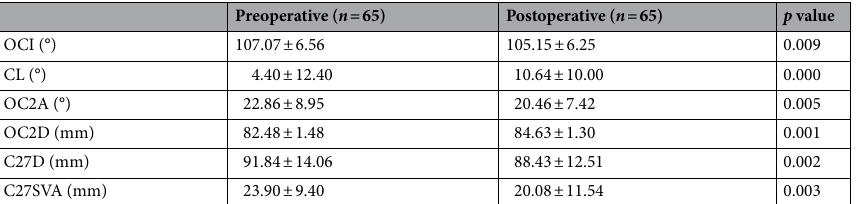
Table 2. Overall patients change of cervical sagittal parameters. All continuous values are in mean ± standard deviation. Values for OCI, CL, and OC2A are degrees, and for OC2D, C27D, and C27SVA are millimeters. OCI, occipitocervical inclination; CL, cervical lordosis; OC2A, occiput-C2 angle; OC2D, occiput-C2 spinous process distance; C27D, C2-C7 interspinous process distance; SVA, C2-C7 sagittal vertical axis. p value below 0.05 is considered statistically